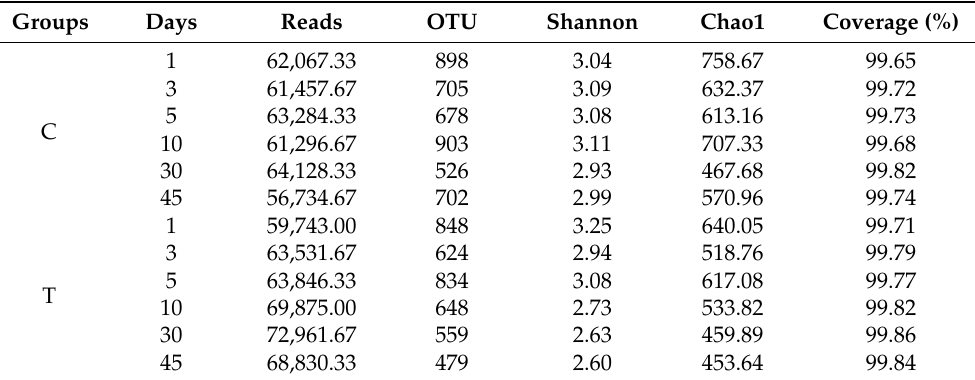
Table 4. Alpha diversity of bacterial diversity in two